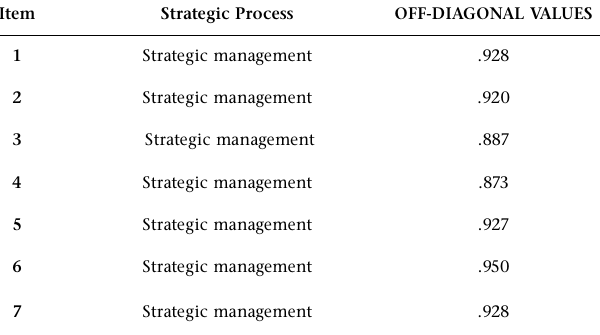
According to table 3 the off-diagonal correlations are above